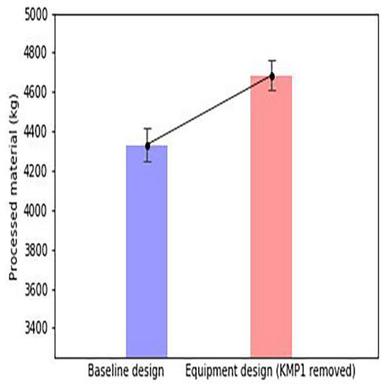
The baseline design processed the product of 4332 ± 81.8 kg while the equipment design processed 4684 ± 75.5 kg. Equipment design could process 350 kg more compared to the baseline design with the same false alarm probability of 5% at each KMP.